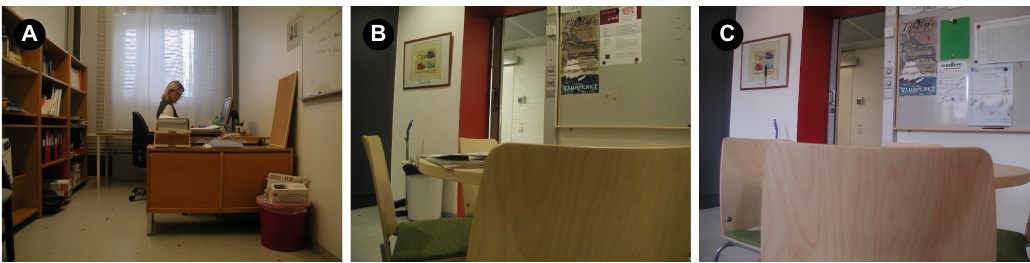
Figure 1. Example images from the INDECS database for cloudy (A), night (B), and sunny (C)